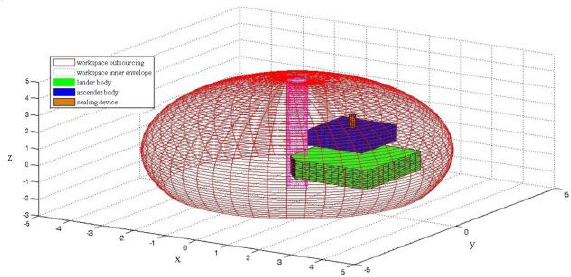
Figure 5. Three-dimensional workspace in the base coordinate